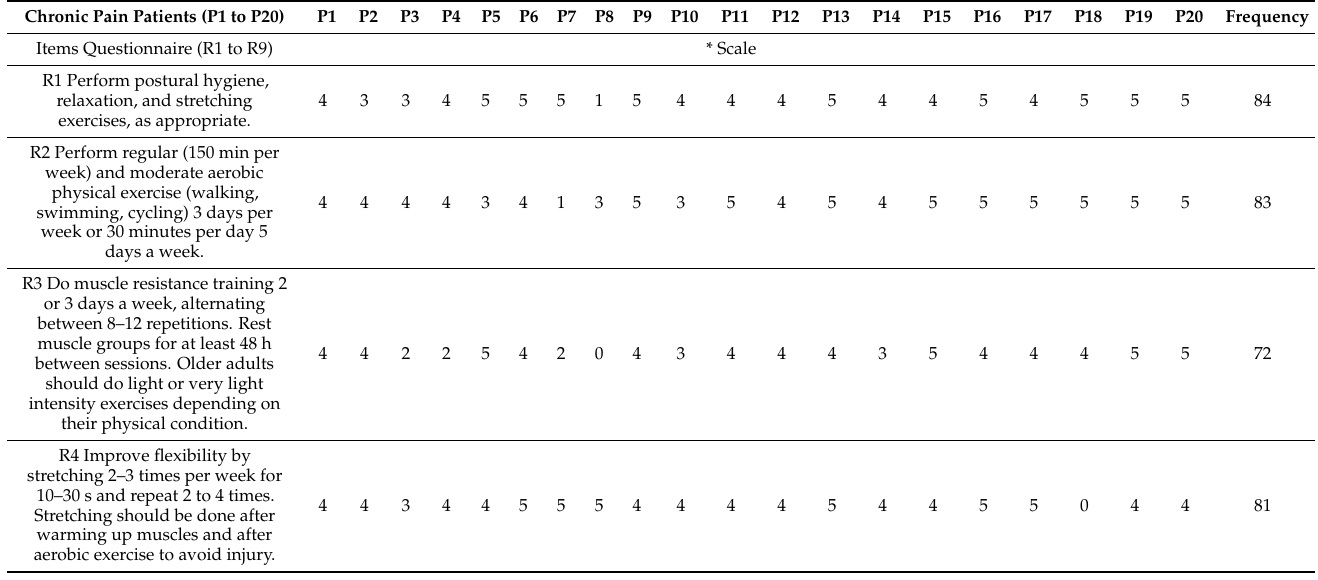
Table 3. Degree to which physical exercise recommendations can improve